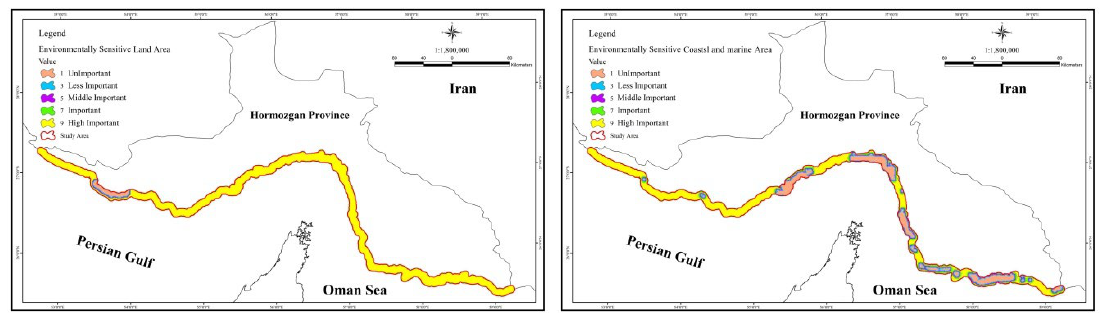
Fig. 7: Evaluated map of distance to environmentally sensitive Fig. 8: Evaluated map of distance to environmentally sensitive land areas coastal and marine Fig. 7: Evaluated map of distance to Fig. 8: Evaluated map of distance to environmentally environmentally sensitive land areas